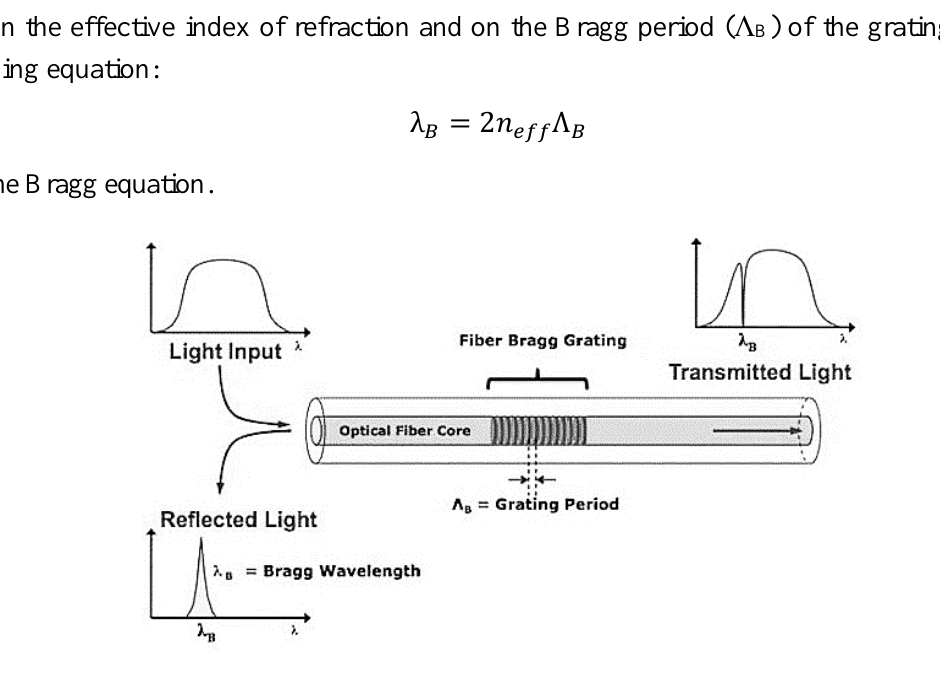
Figure 3. Fibre Bragg Grating’s principle of